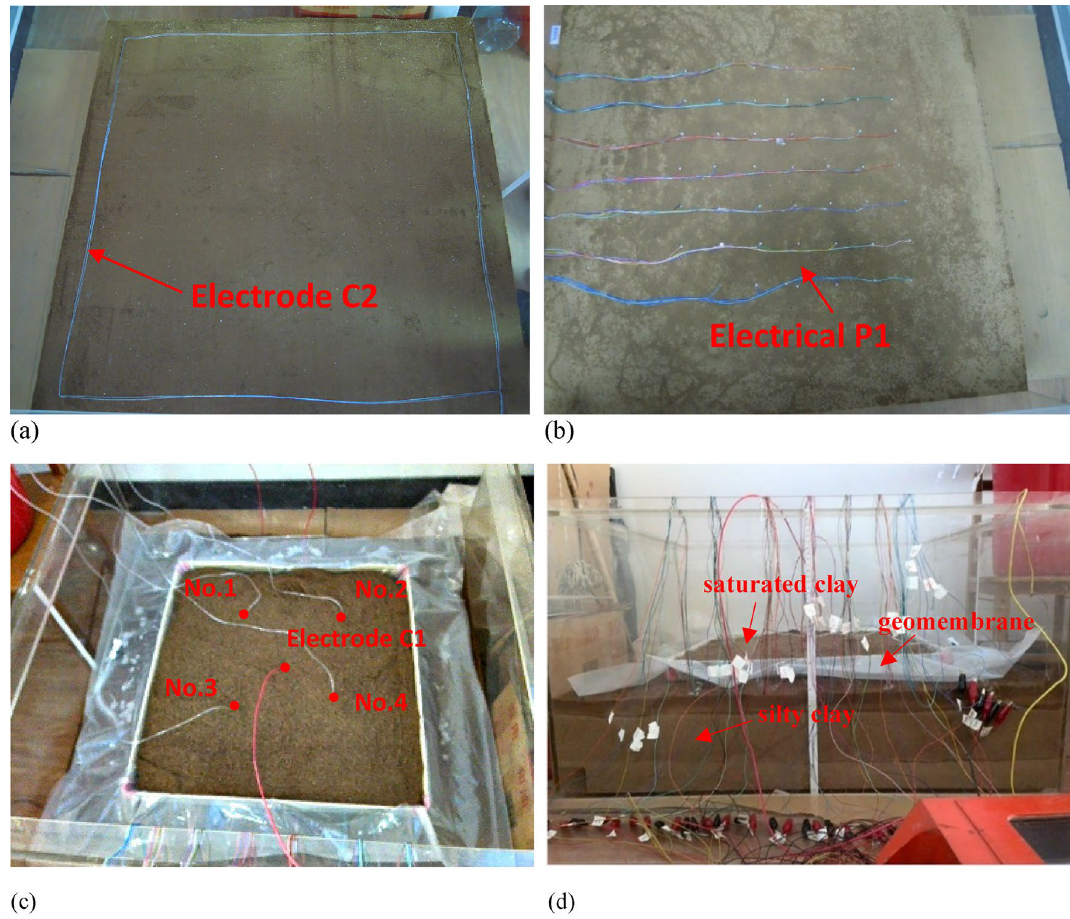
Figure 2. Set-up of leachate migration simulation experiment: ( a ) Schematic diagram of electrode C2 layout; ( b ) Schematic diagram of electrical system laying; ( c ) Position of electrode C1 and leakage point; ( d ) Schematic diagram of simulated experimental soil layer.